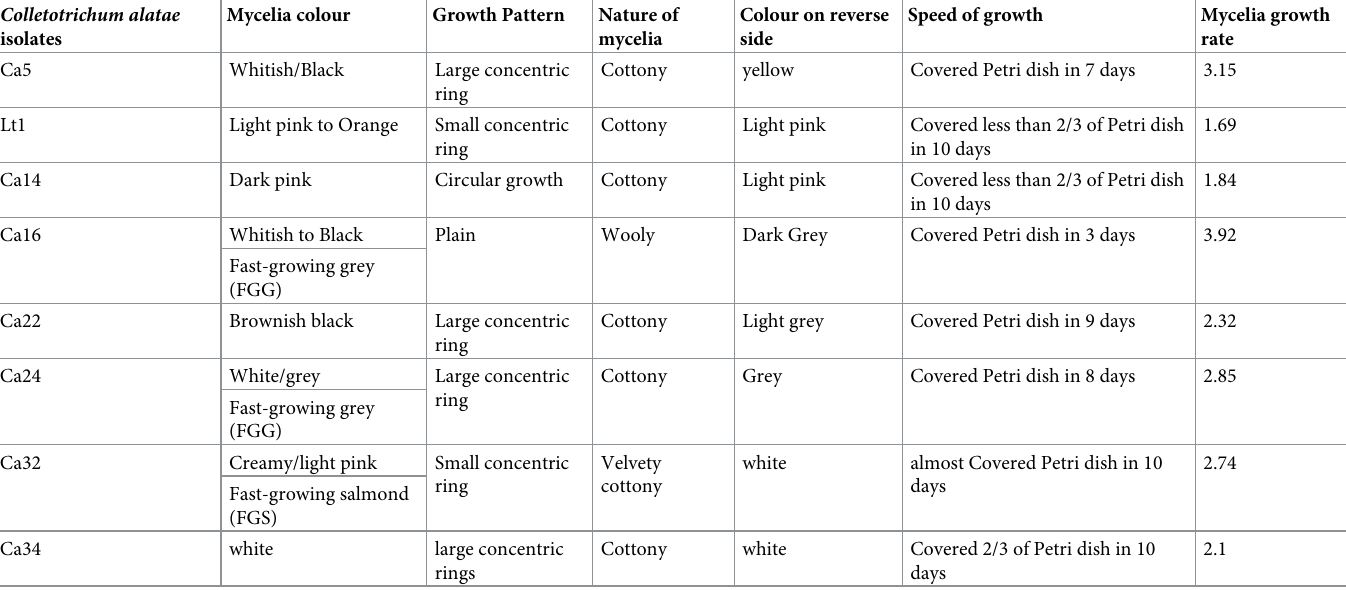
Table 3. Cultural characteristics of Colletotrichum alatae isolates. Colletotrichum alatae